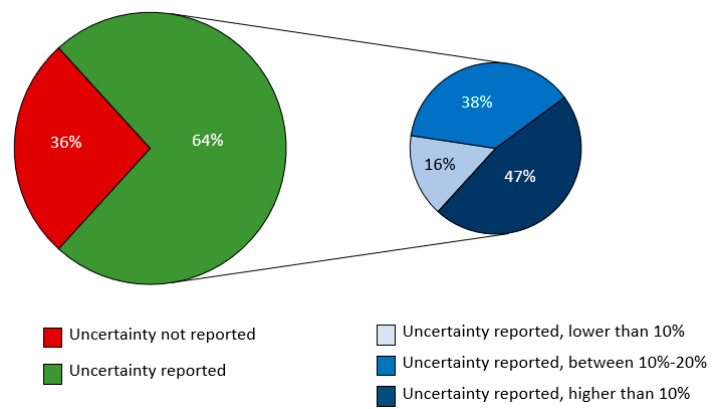
Figure 2. Proportion (%) of FREL submissions to the UNFCCC that include uncertainty estimates ( left ); for those that report uncertainty, the proportion (%) of submitted FRELs with uncertainty below 10%, between 10% and 20%, and above 20% are indicated on the right pie.